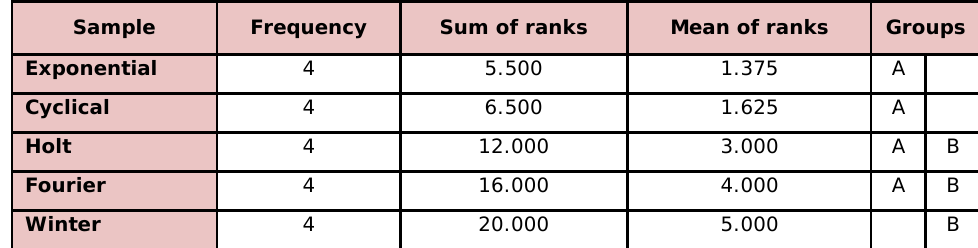
Table 7. “Multiple pair wise comparisons for forecasting accuracy using the Nemenyi’s